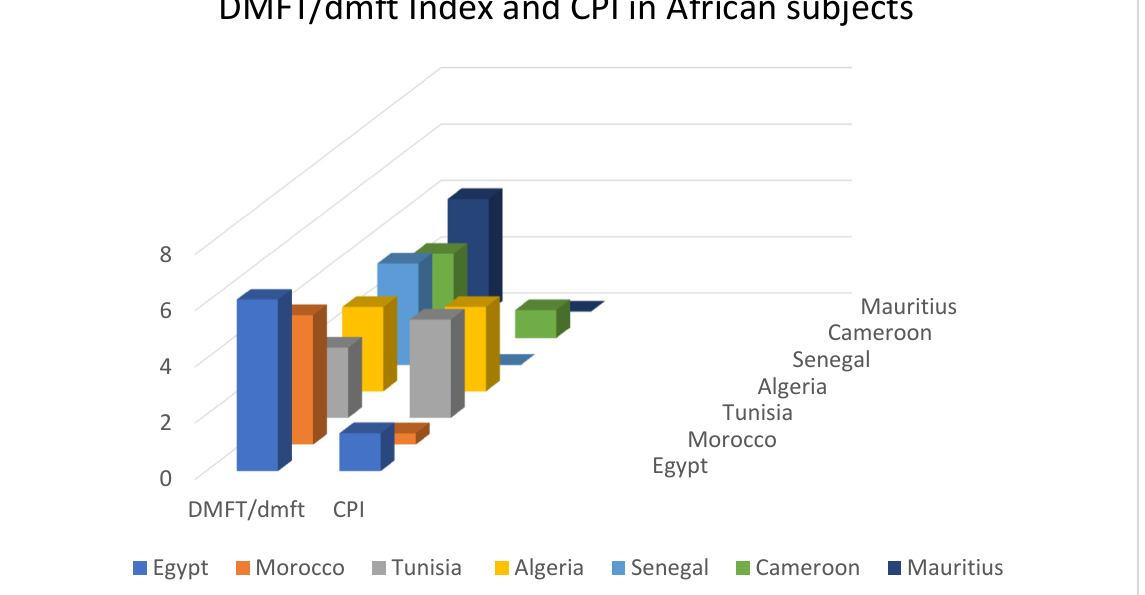
Figure 1. DMFT/dmft Index and CPI (means) in African patients.